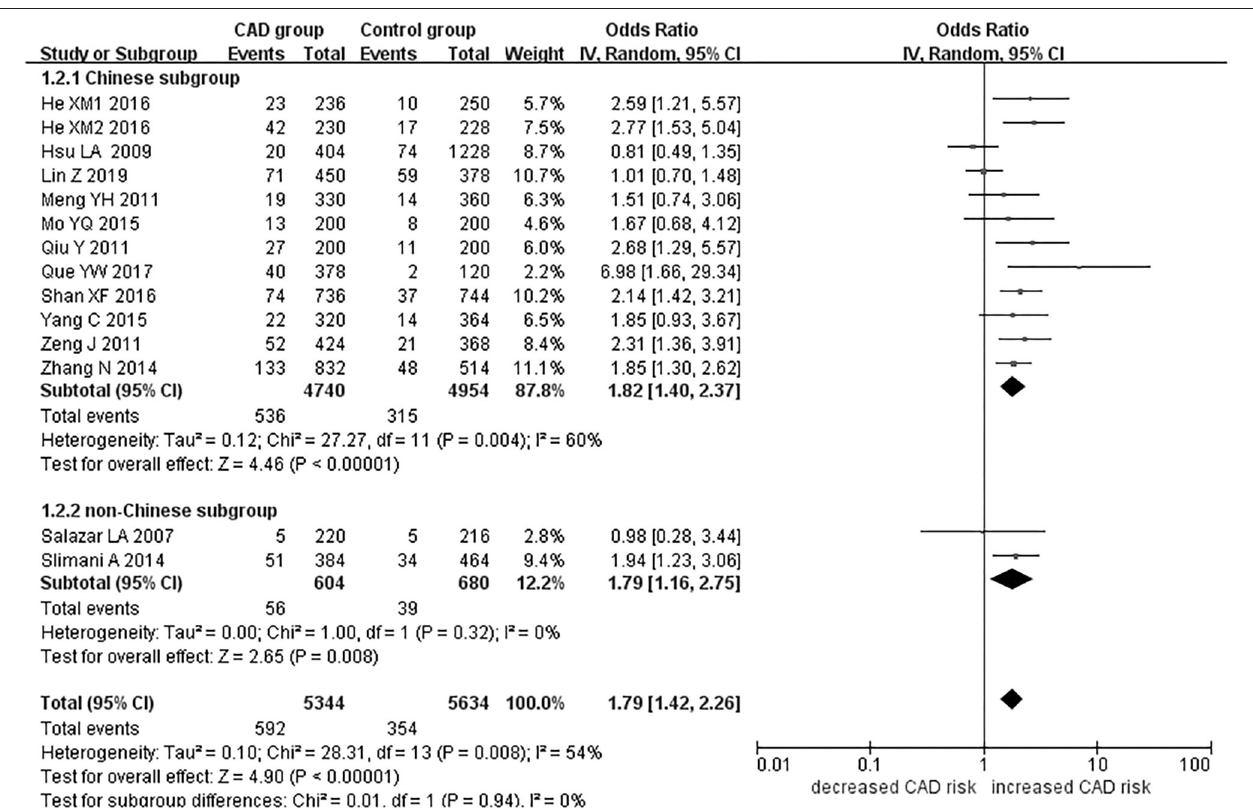
FIGURE 1 | Forest plot of CAD associated with PCSK9 gene E670G polymorphism under an allelic genetic model (distribution of G allele frequency of PCSK9 gene E670G polymorphism).